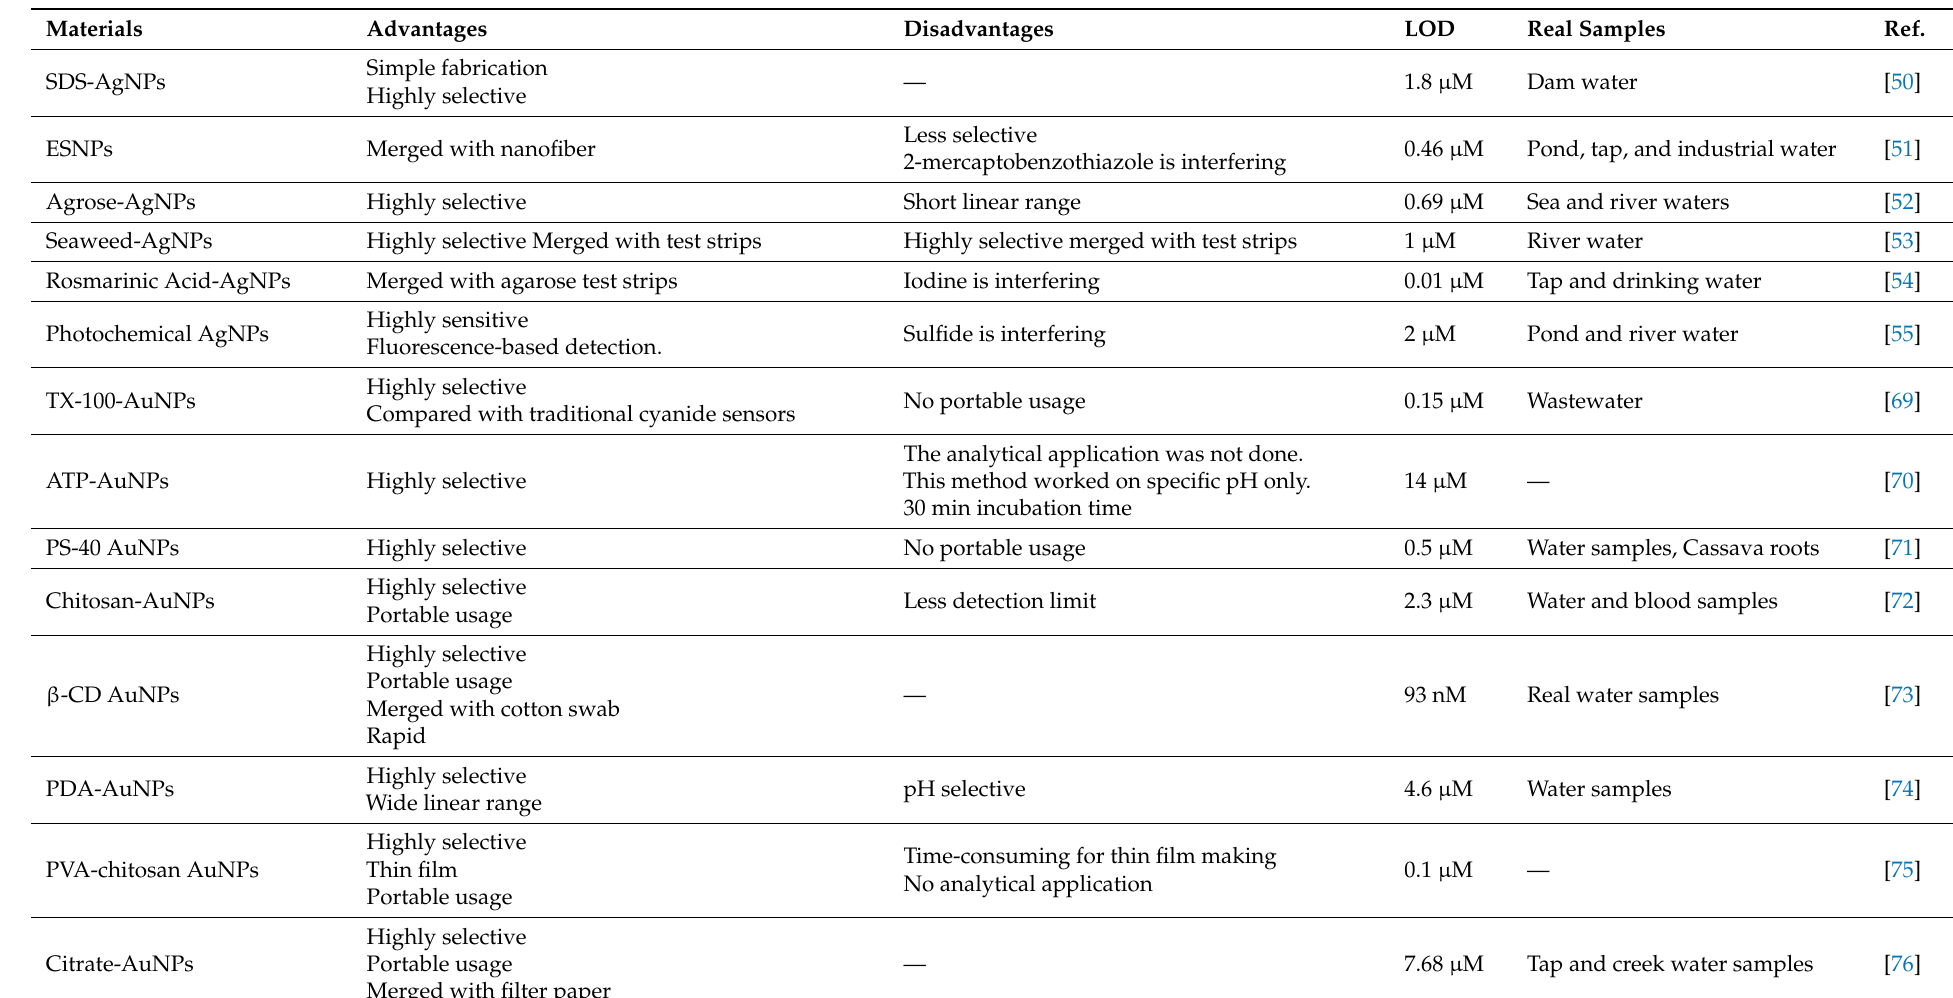
Table 1. Analytical merits of plasmonic metal nanoparticles based colorimetric